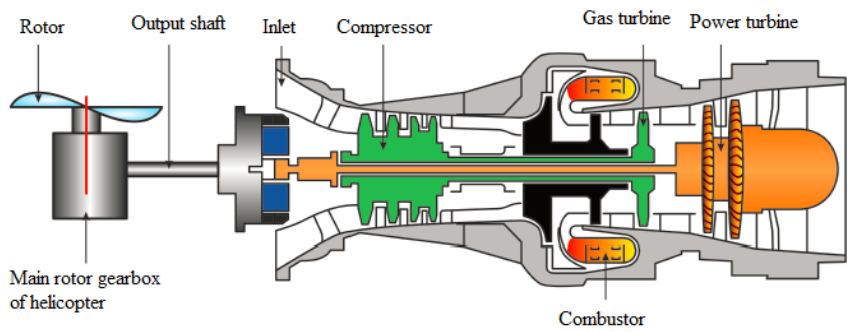
Figure 1. Structural sketch of turbo-shaft engine.